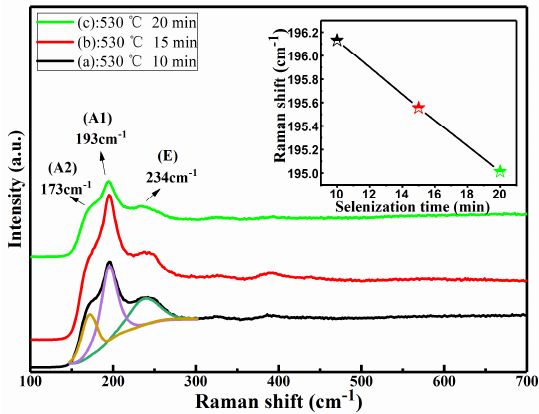
Figure 8. Raman spectra of the CMZTSSe films annealed for different times. Inset: The main Raman peaks of A1 mode for CMZTSSe films annealed for different times.